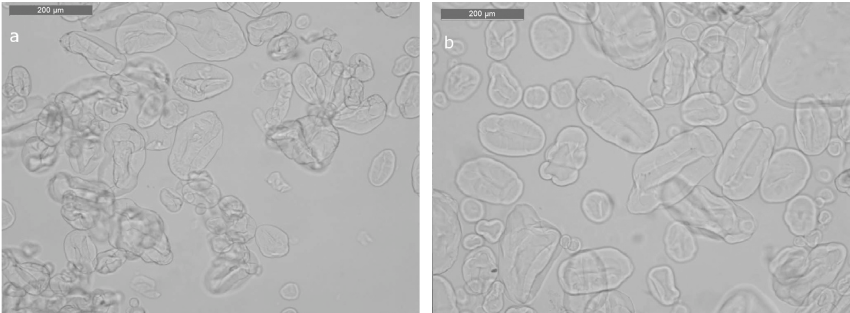
Figure 17: Hydrogels for CMS/CS 64: (a) after of gelation time and (b) before of gelation